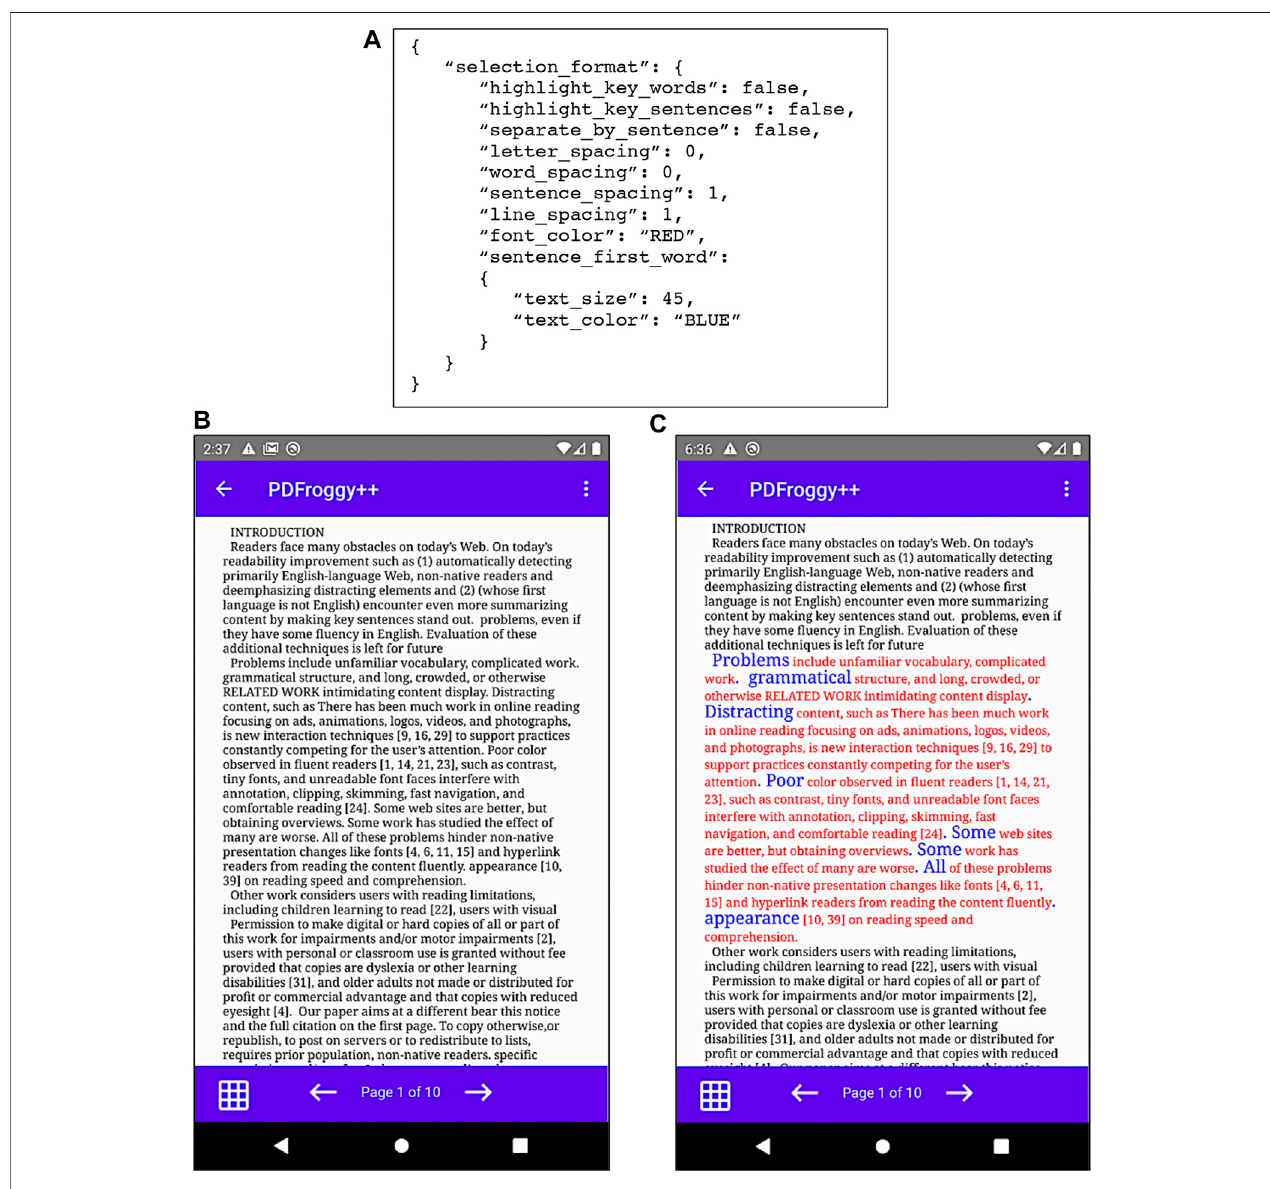
FIGURE10|(A) AnexampleofgestureformattingJSON fi le; (B) OriginalPDFview; (C) Formattedcontentofselectedparagraph — leadingcharactersareenlarged and marked with blue colors, and selected paragraph is marked with red